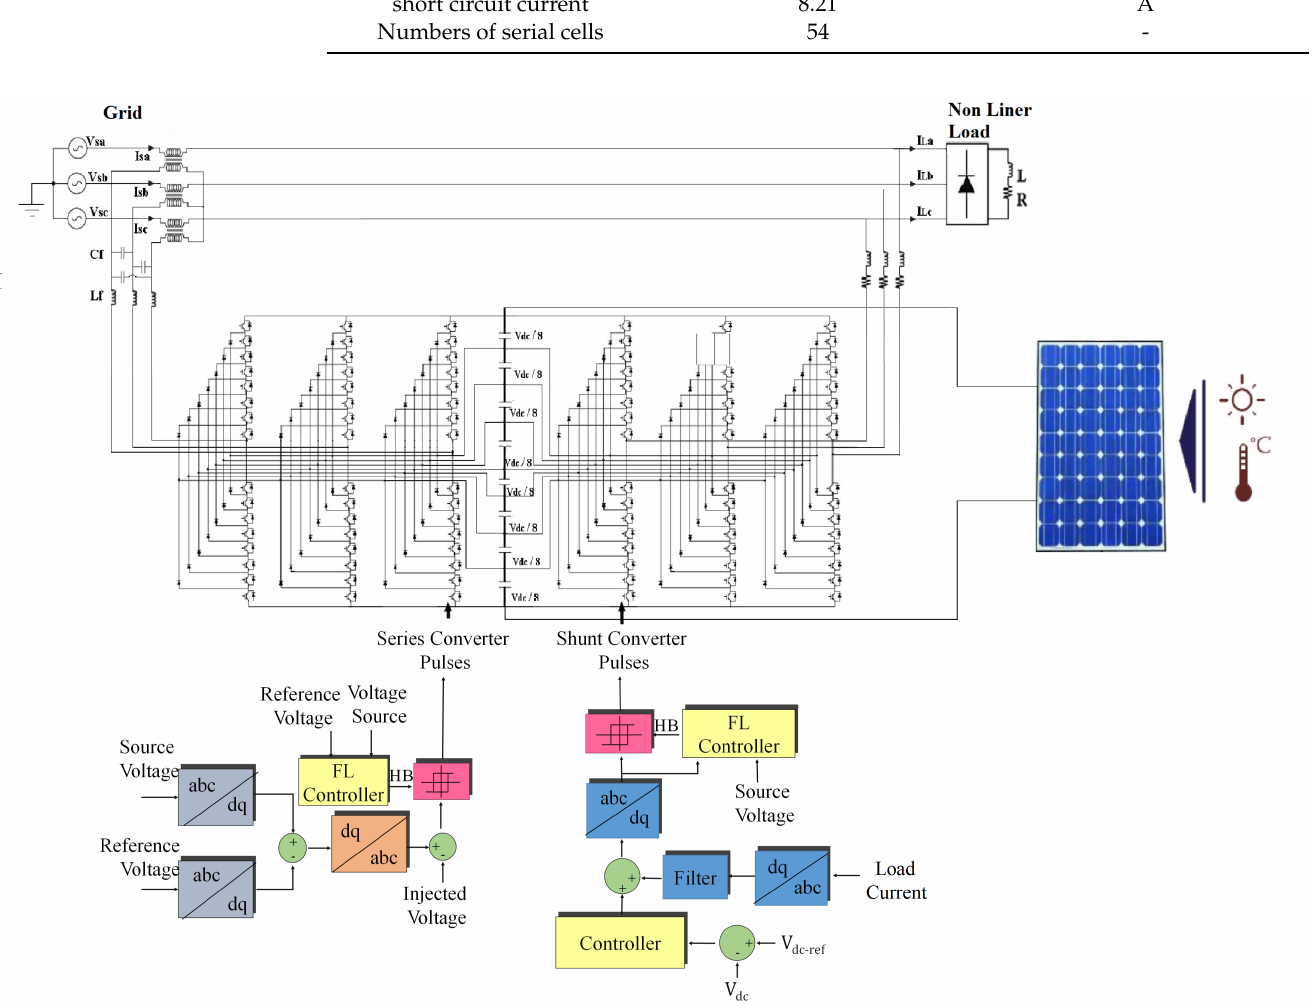
Figure 8. Simulation of the suggested